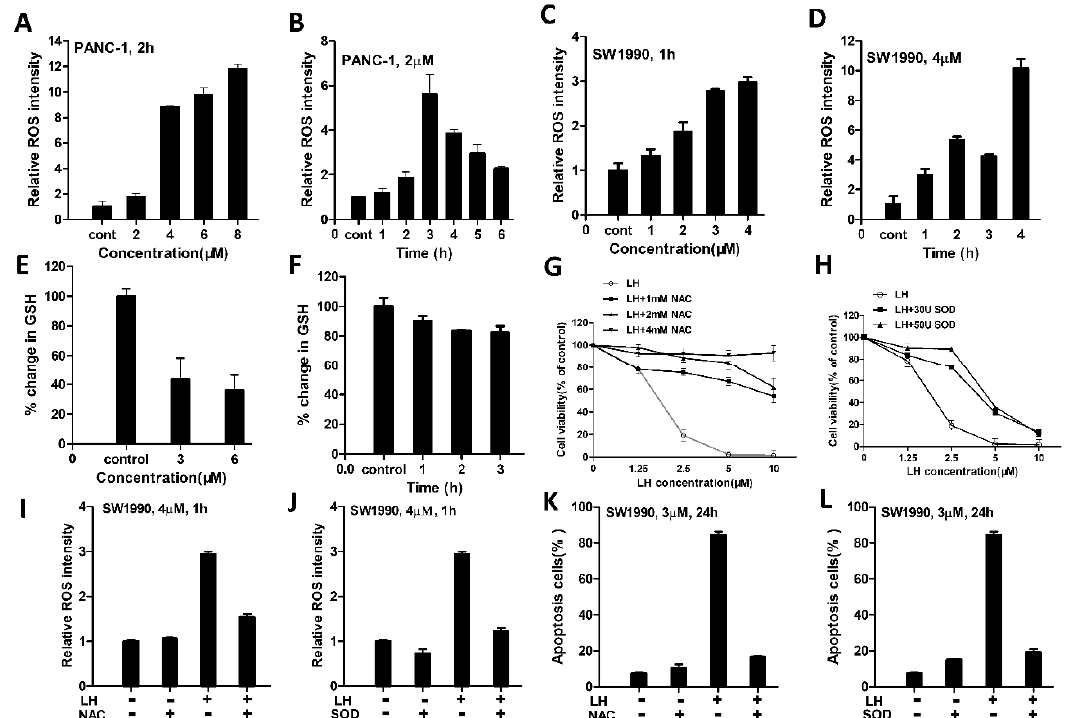
Figure 2. LH induced-ROS accumulation is involved in its antitumor activity. ( A ), ROS levels in PANC-1 cells were assessed after 0, 2, 4, 6, 8 µ M LH treated for 2 h by fluorescent probe DCFH/DA staining and determined by flow cytometry. ( B ), PANC-1 cells were incubation with 2 µ M LH for 0, 1, 2, 3, 4, 5, 6 h, and ROS levels were measured as mentioned above. ( C ), SW1990 cells were treated with 0, 1, 2, 3, 4 µ M of LH for 1 h and then ROS levels were assessed as mentioned above. ( D ), SW1990 cells were treated with 4 µ M LH for 0, 1, 2, 3, 4 h, and then ROS levels were measured as mentioned above. ( E ), LH dose dependently decreased intracellular GSH levels. GSH levels were measured after SW1990 cells treated with 0, 3, 6 µM LH for 2 h by GSH and concentration for 30 min, the cell viability ( G , H ) was determined by CCK8 assay after incubated with 0, 1.25, 2.5, 5, 10 µ M LH for 48 h, the levels of ROS ( I , J ) were determined by flow cytometry after incubated with 4 µ M LH for 1 h, the